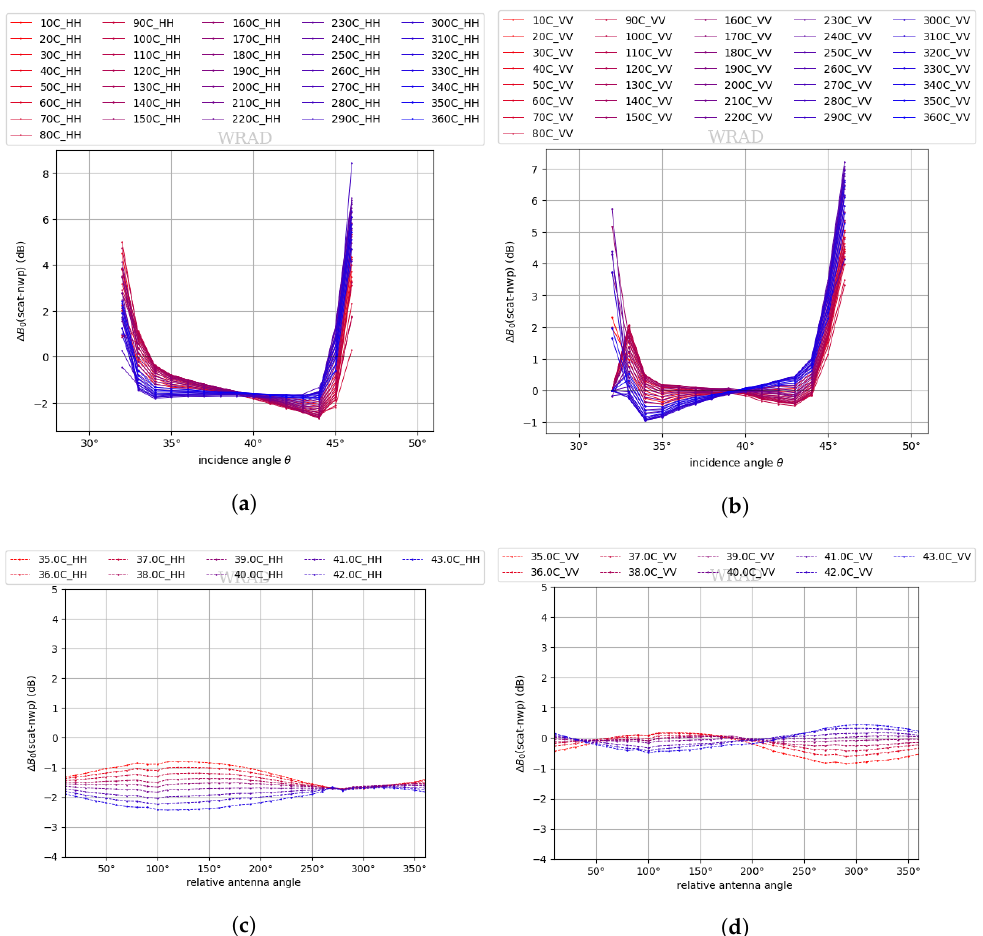
Figure 12. C-band NOCant (NOC as a function of incidence angle and relative antenna angle) for descending orbits. The upper panel is as a function of incidence angle ( x -axis) per relative antenna angle (red to blue lines), the lower panel is as a function of relative antenna angle ( x -axis) per incidence angle (red to blue lines): ( a , c ) HH polarization; ( b , d ) VV